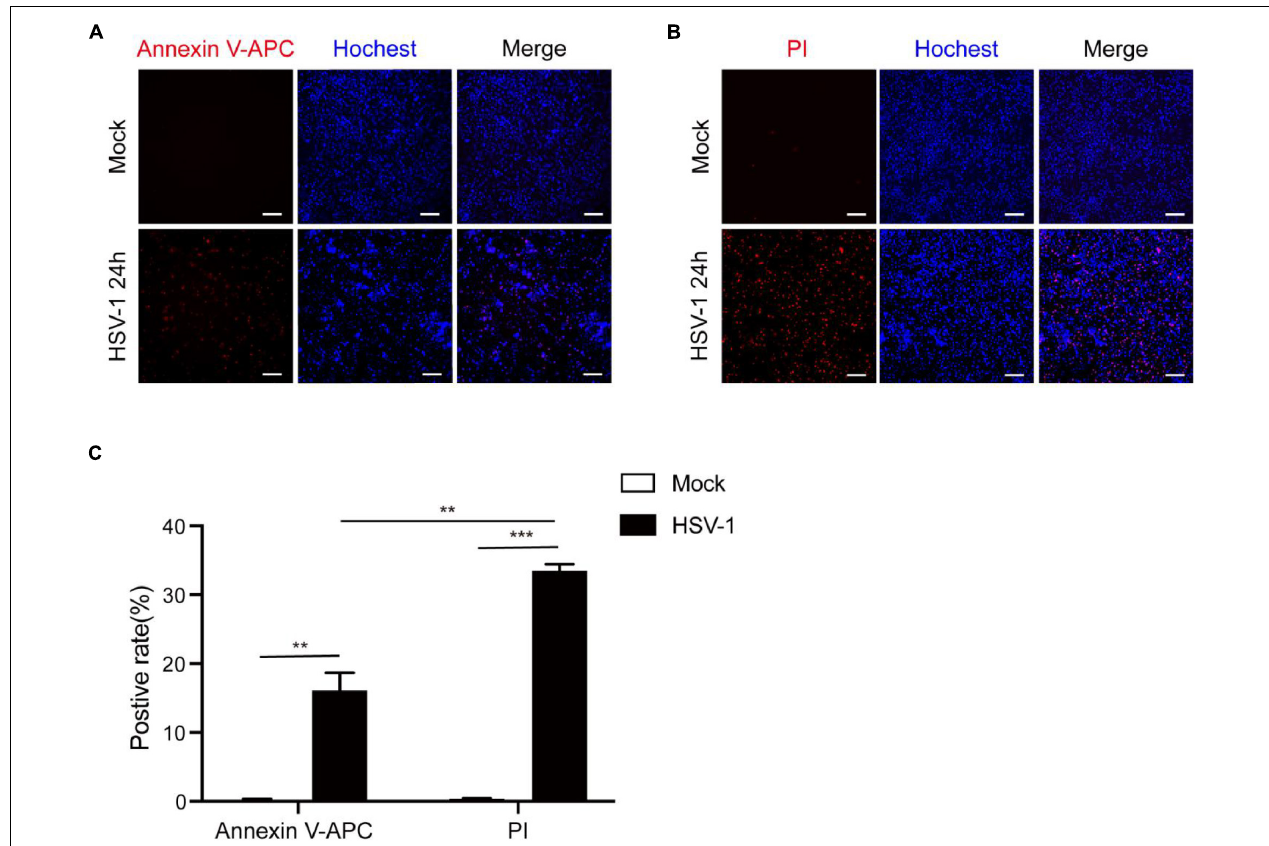
FIGURE 1 | HSV-1 induces cell death in cultured BV2. (A) Representative micrographs of Annexin V-APC and Hoechst 33342 staining of BV2 with Mock or HSV-1 (MOI = 5) infection. Red: Annexin V-APC; blue: Hoechst 33342 dye (Scale bar, 100 µ m, 10 × ). (B) Representative micrographs of propidium iodide (PI) and Hoechst 33342 staining BV2 cells with Mock or HSV-1 (MOI = 5) infection. Red: PI dye; blue: Hoechst 33342 dye (Scale bar, 100 µ m, 10 × ). (C) Quantification of the number of PI + cells and Annexin V-APC + cells relative to mock and HSV-1 infection are shown in the histogram. All data are presented as mean ± SD, Student’s t -test, ** P < 0.01, *** P <